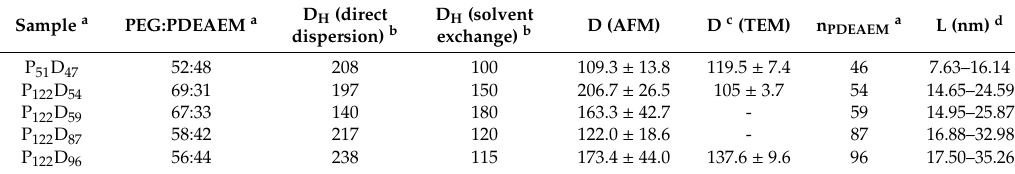
Table 2. Dynamic light scattering and microscopy analysis for polymer aggregates (sizes in nm).